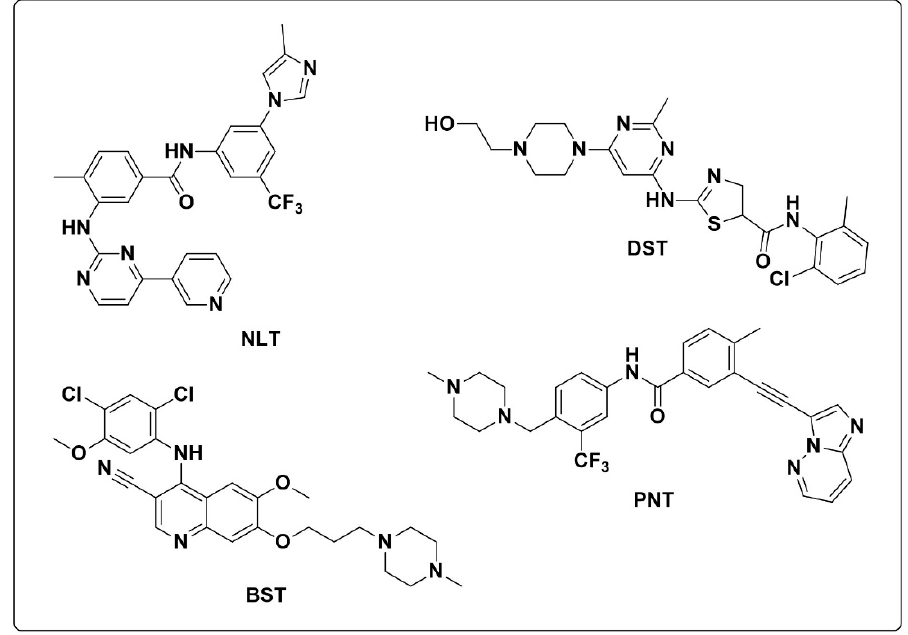
Figure 2. Tyrosine kinase inhibitors approved for the treatment of chronic myeloid leukemia (CML).